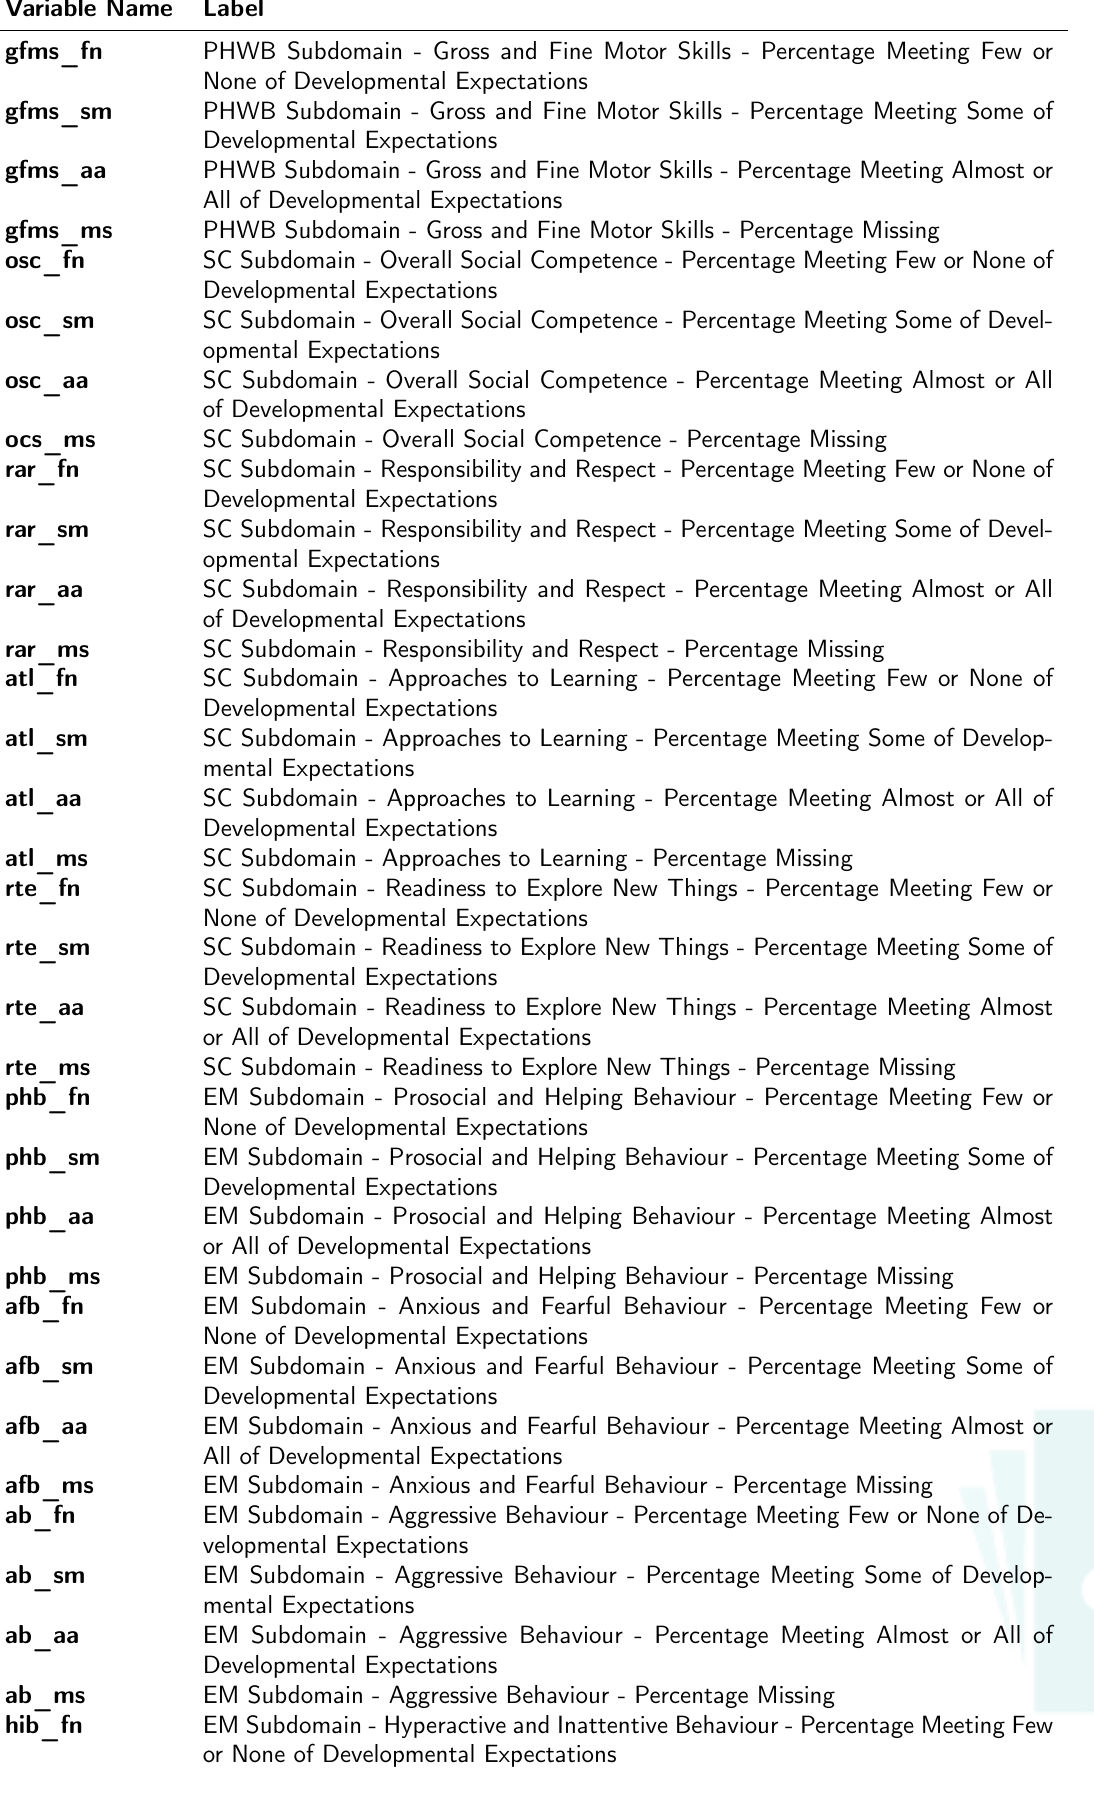
Supplemental Table 1. cont. Early Development Instrument Variables in the CanNECD Database Variable